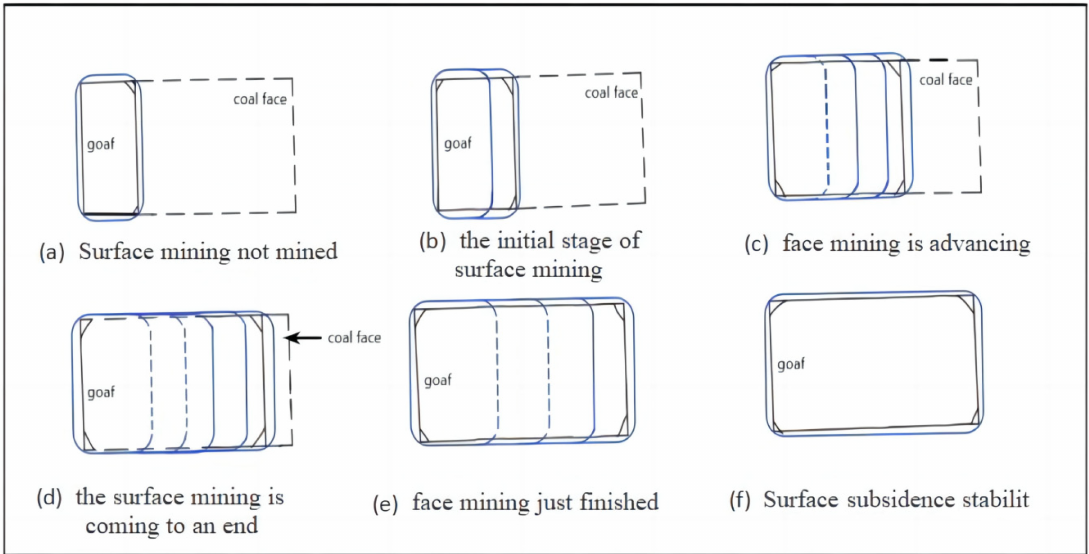
Figure 5. Dynamic development process of surface